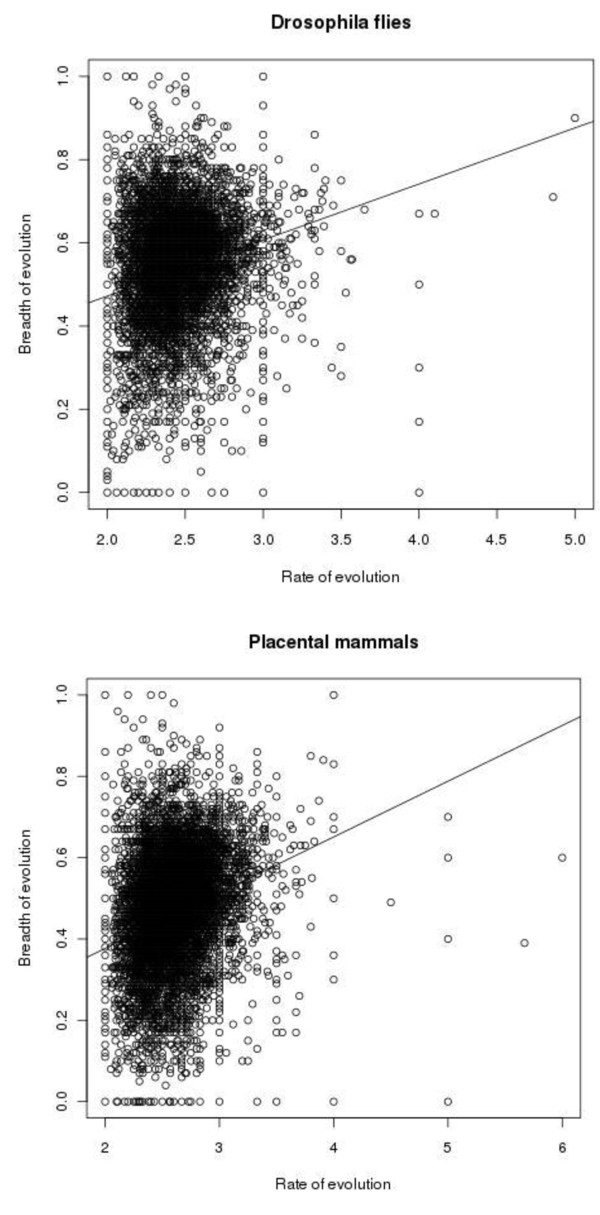
Rates and breadths of evolution of all proteins in Drosophila flies (left) and placental mammals (right) calculated using classes of amino acids.